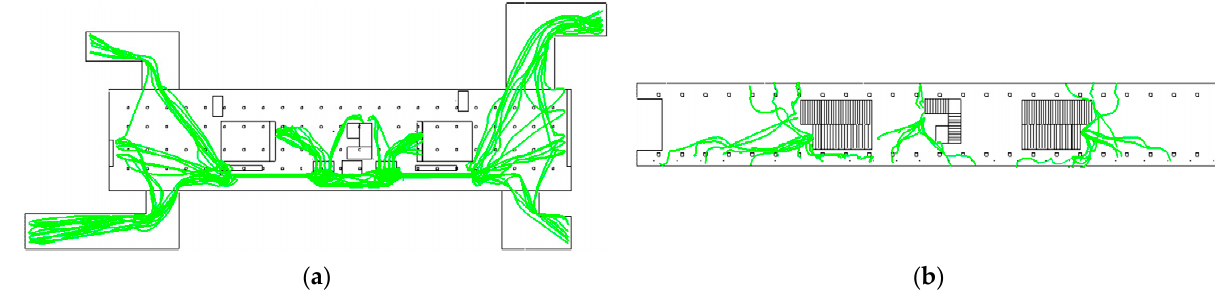
Figure 20. The streamlines of 50 boarding pedestrians: ( a ) Concourse floor; ( b ) Platform floor.